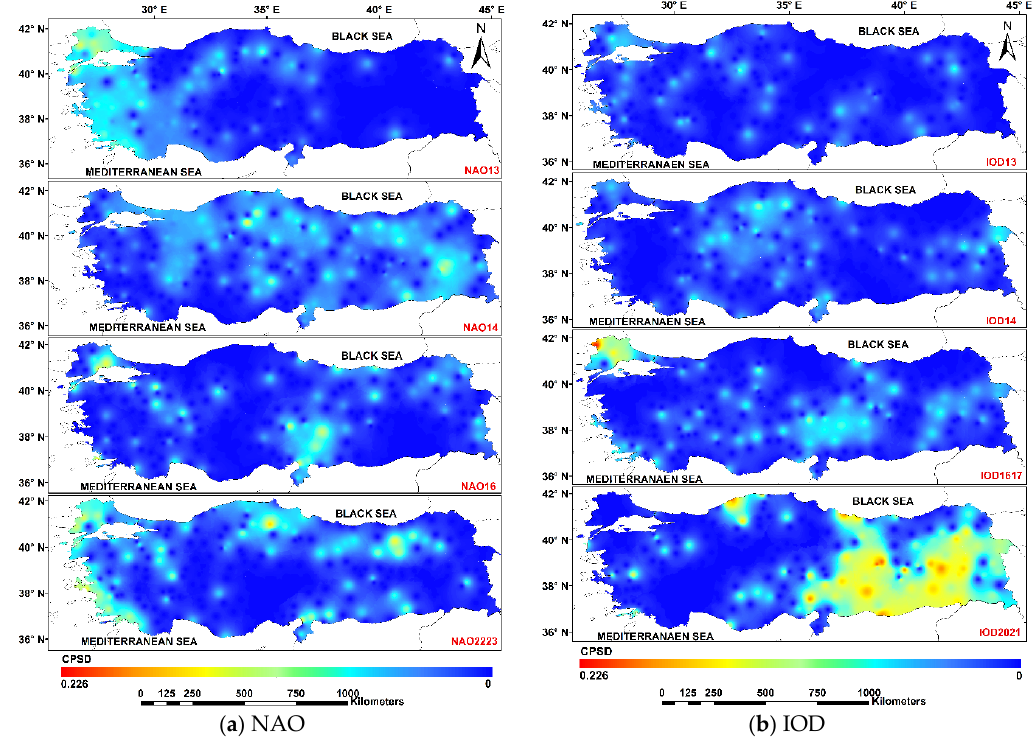
Figure 16. Spatial distribution of CPSD values ( a ) for NAO ( b ) for IOD. According to Figure 15a, phase shift values between the NAO and meteorology sta- tions were clustered for the 13-month period in the west of Turkey, for the 14-month pe- riod in the inner west and east of Turkey, for the 16-month period in the south of Turkey, and for 22–23-month period in the west and north of Turkey. The phase shift values be- tween the NAO and meteorological stations were mostly clustered in the west for the 22– 23-month periods. This means that the stronger relationships were observed in the west because the Atlantic Ocean is closer to the west of Turkey.